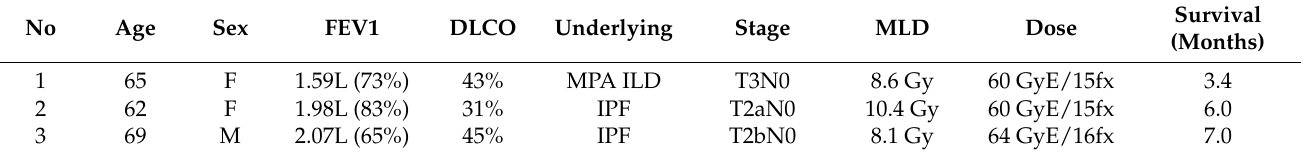
Table 4. Clinical characteristics and course of patients with grade 5 pulmonary